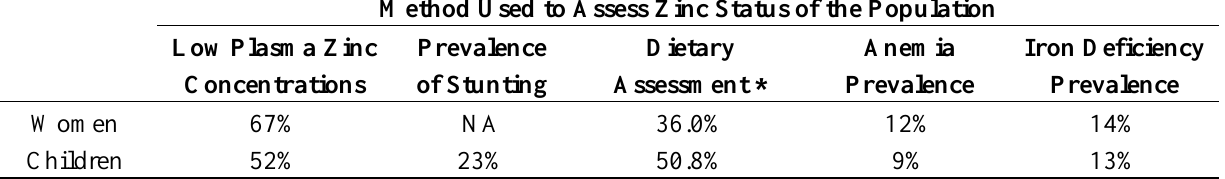
Table 1. Prevalence of low “zinc status” in Vietnamese women of reproductive age ( n = 1526) and their children aged 6–60 months ( n =